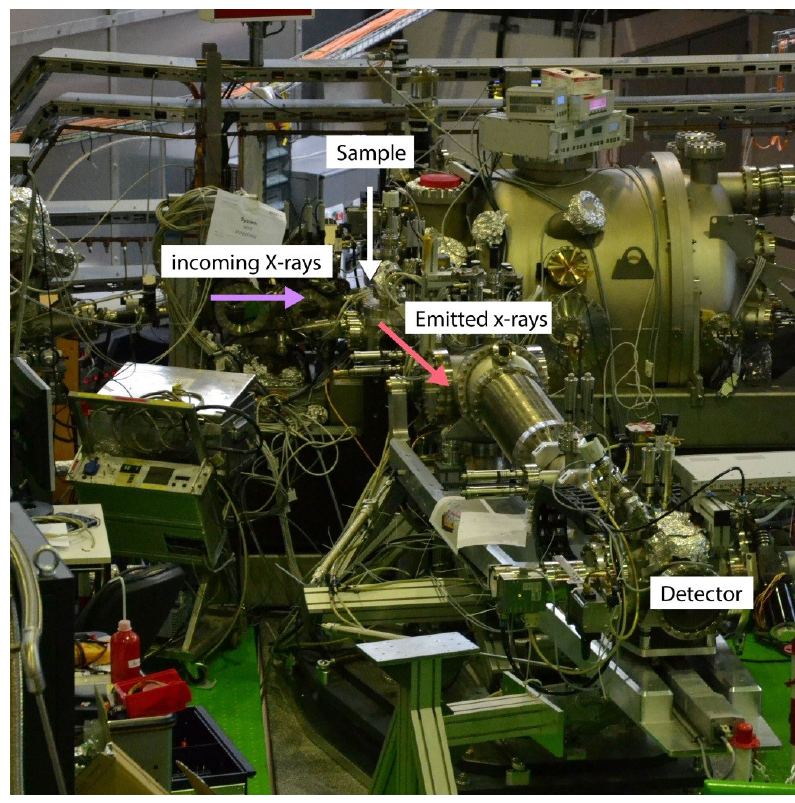
Figure 1: View of the µ mRIXS spectrometer.